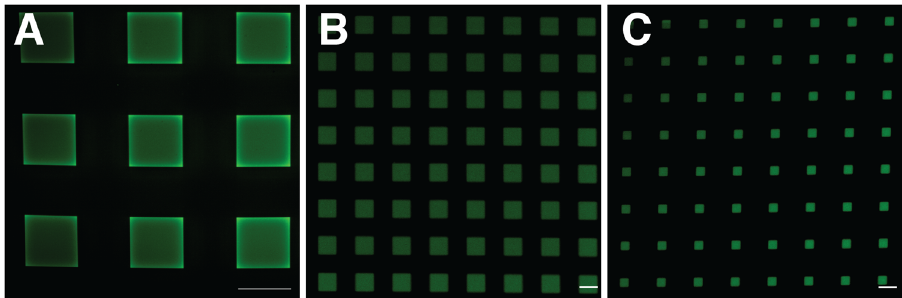
Fig. 5 Square micropatterns of 5FAM-GCGYRGDSPG-peptide on HA-am hydrogels could be achieved using different masks. A 200 × 200 µm 2 , 200